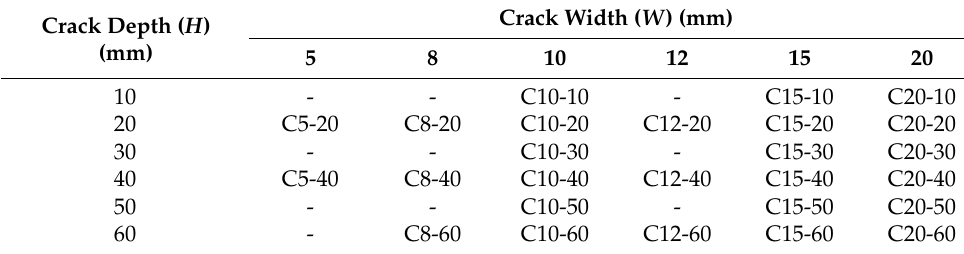
Table 1. Name of test